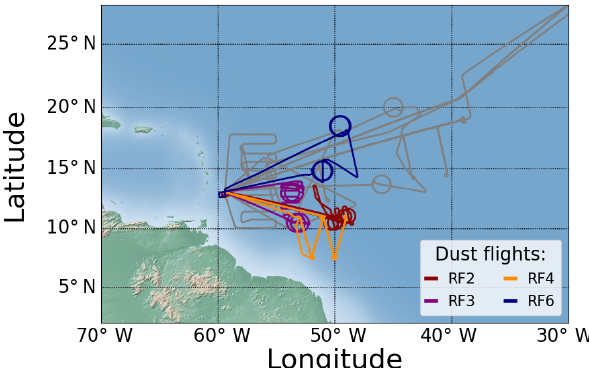
Figure 1. NARVAL research flight tracks: NARVAL-II dust-flights (color coded) and NARVAL-I and NARVAL-II dust-free flights